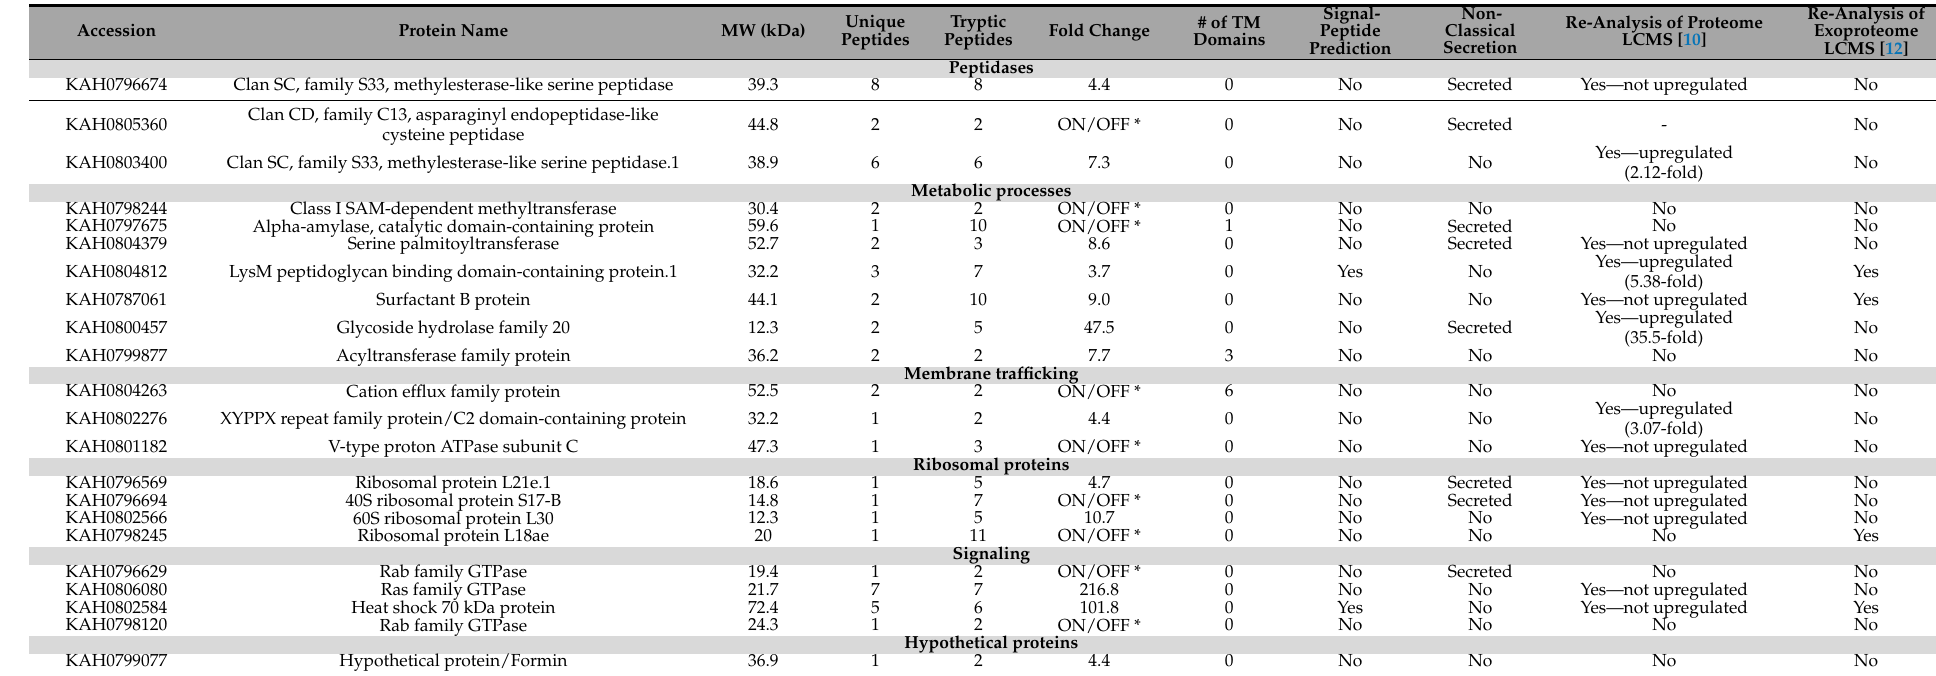
Table 1. List of upregulated proteins identified with LC-MS analysis on the surface of the virulent H. meleagridis